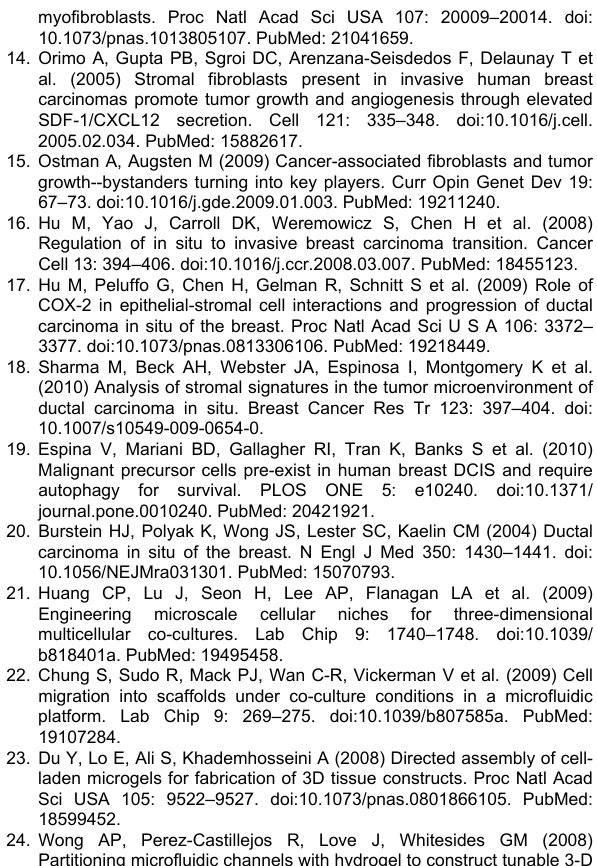
Figure S6. Averaged aspect ratio of MCF-DCIS clusters and the mean intensity of SHG. (A) MCF-DCIS cluster (co- cultured with 3D HMF) shape analysis by estimating averaged aspect ratio. Both HGF neutralizing antibody and c-met inhibitor (anti c-met) decreased the aspect ratio of MCF-DCIS clusters and the mean intensity of SHG in 3D/3D co-culture. ‡ represents a p value of less than 0.05. (B) The average aspect ratio of MCF-DCIS clusters and the mean intensity of SHG with 2D HMF.